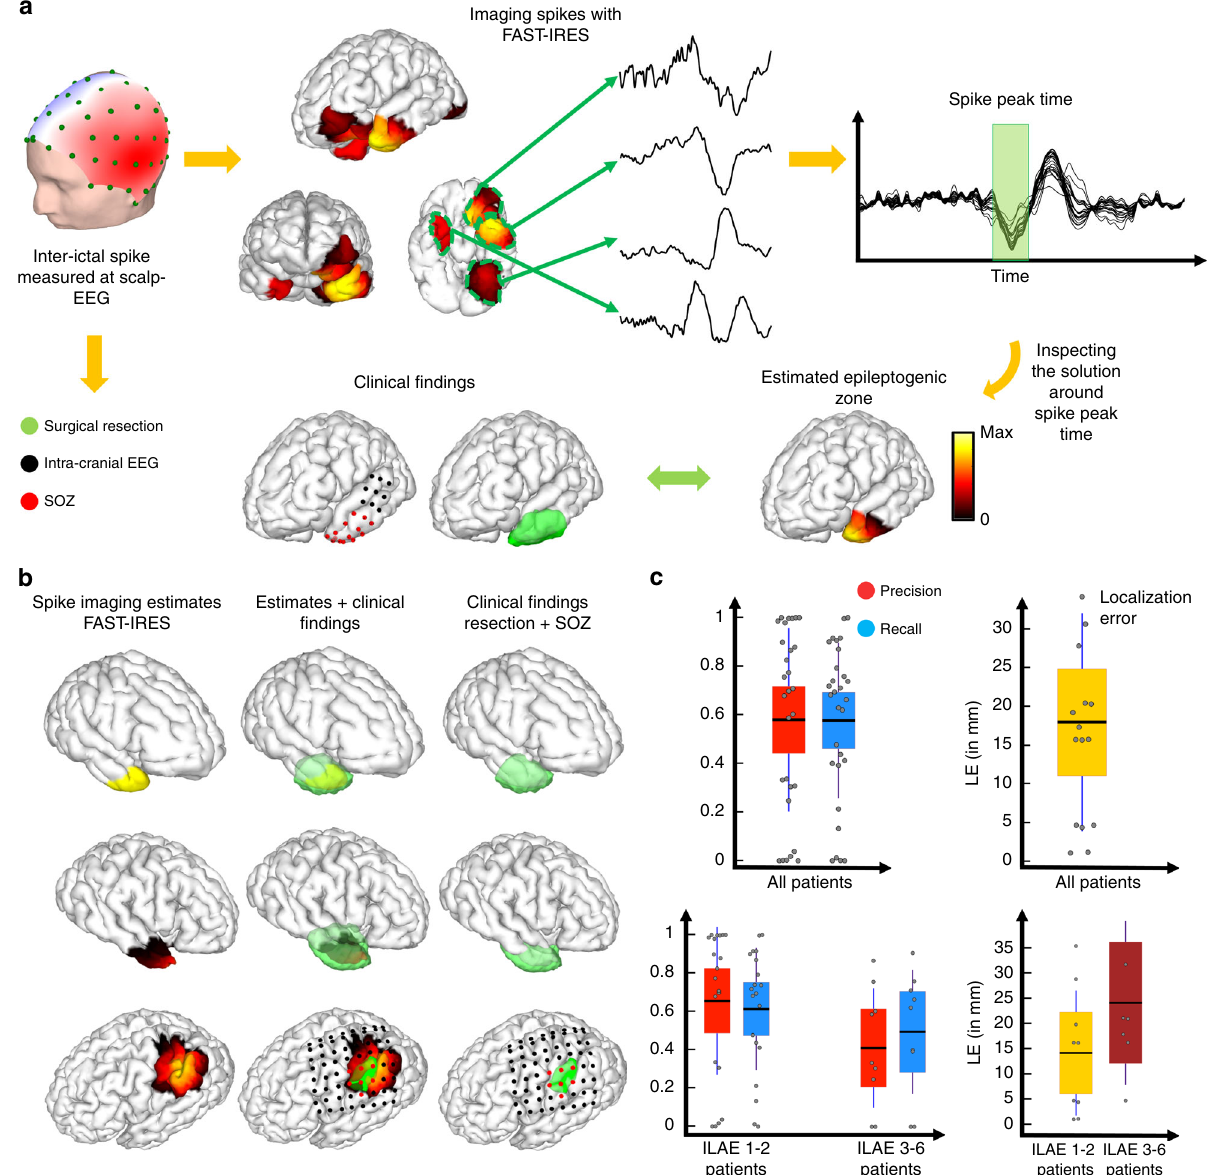
Fig. 4 Spike imaging overview and results. a The output of FAST-IRES is a spatiotemporal distribution where spatial distributions correspond to a time- course of activity. To determine the epileptogenic tissue, the source signals ’ energy is calculated around the spike peak-time and compared to clinical fi ndings for validation. b Examples of spike-imaging results along the clinical fi ndings in the same patients. c Quantitative results of spike-imaging results for all patients (top) and separated based on surgical outcome (bottom). Note that while the color scheme distinguishes precision vs. recall in these patients, for localization error it is used to denote seizure-free from non-seizure-free patient groups (bottom). Each gray circle corresponds to individual patient ’ s data. The horizontal black bar indicates the mean, the color bars indicate the 95% con fi dence interval for the mean and the dark vertical bars indicate the standard deviation. To compute precision ( n = 29, 0.58 ± 0.38) and recall ( n = 29, 0.58 ± 0.32), 29 data points were available in total ( n = 29). The same analysis for seizure-free patients yielded higher precision ( n = 20, 0.65± 0.39) and recall ( n = 20, 0.61 ± 0.32) compared to the precision ( n = 9, 0.41 ± 0.31) and recall ( n = 9, 0.49 ± 0.32) in the non-seizure-free group. The localization error ( n = 16, 18.1 ± 14.08 in mm) was calculated from the data